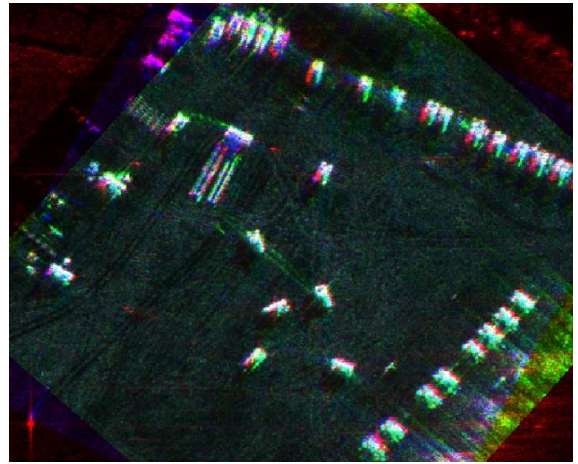
Figure 17. A multi-angle fusion result of a large scenario area.